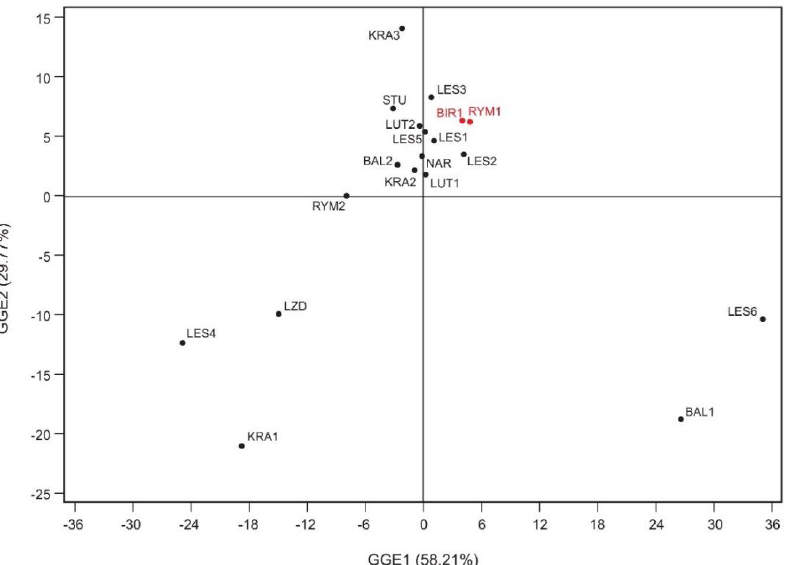
Figure 5. Distribution of genotypes on the GGE-type biplot. Principal component GGE1 describes the height, while GGE2 describes the size of the GE interaction. Position of the BIR1 and RYM1 populations, closest to the IG point marked in red.